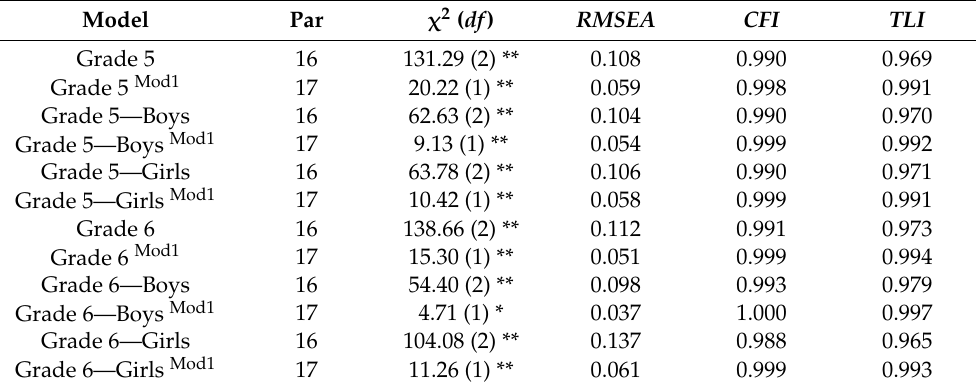
Table 2. Measures of fit to the data of the one-factor confirmatory model PIQ-SI.